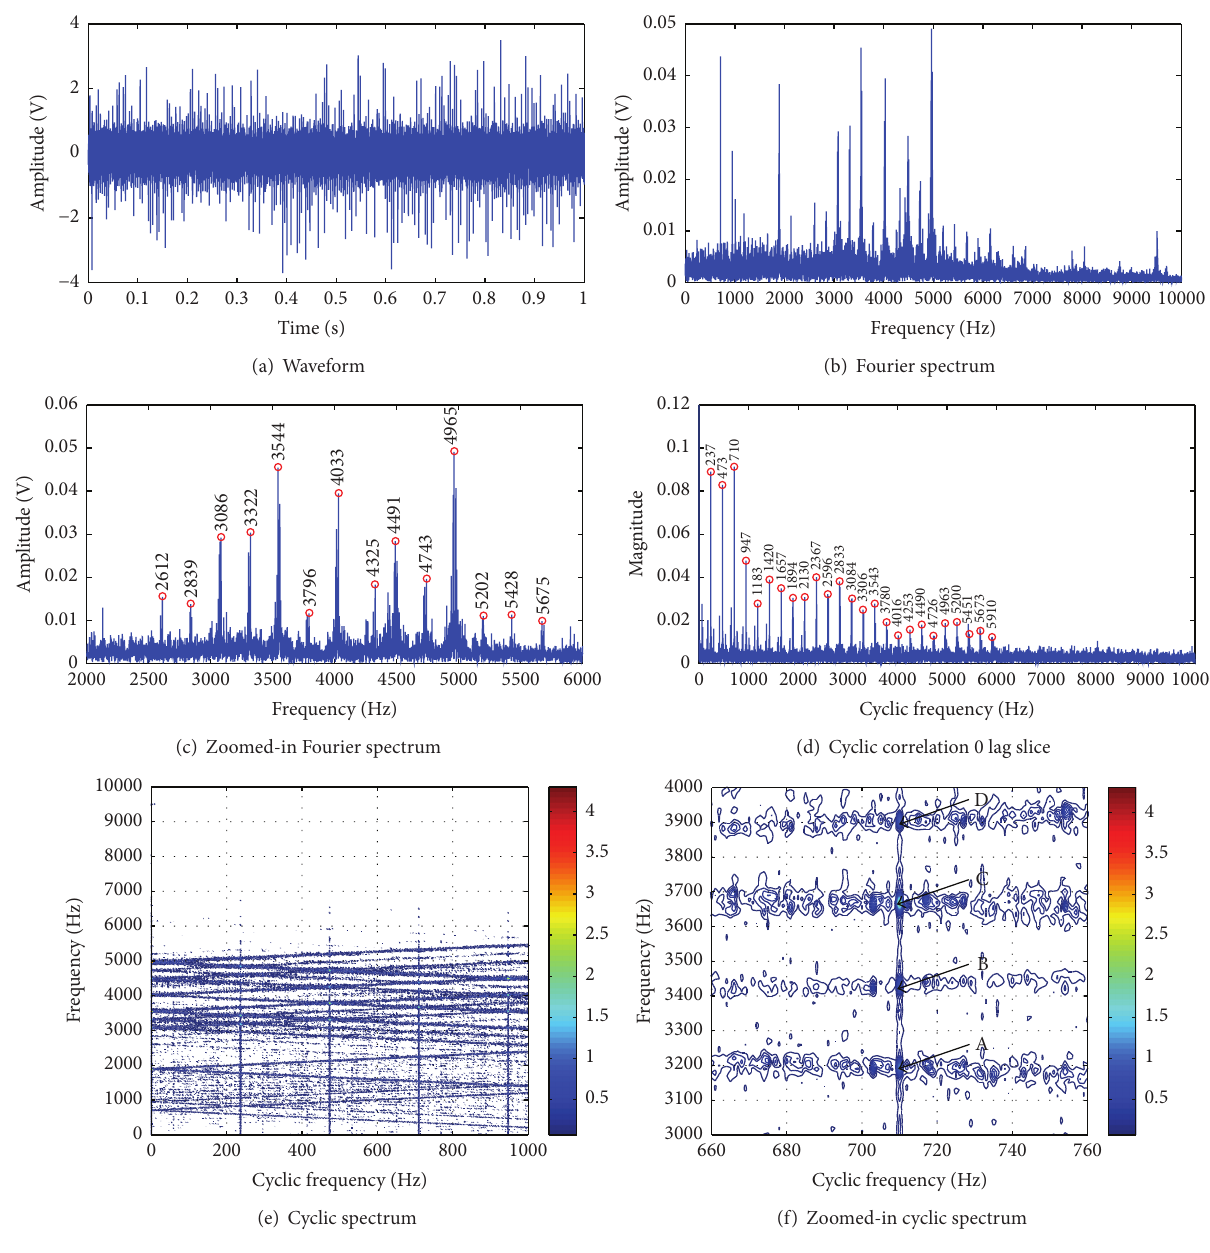
Figure 8: Faulty bearing